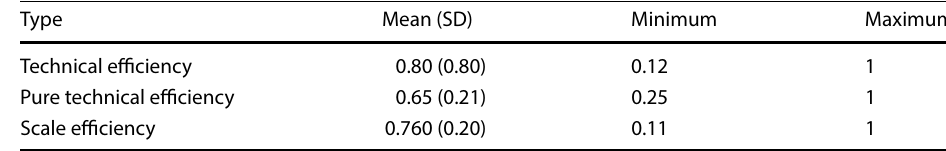
Table 7 Average efficiency of wheat